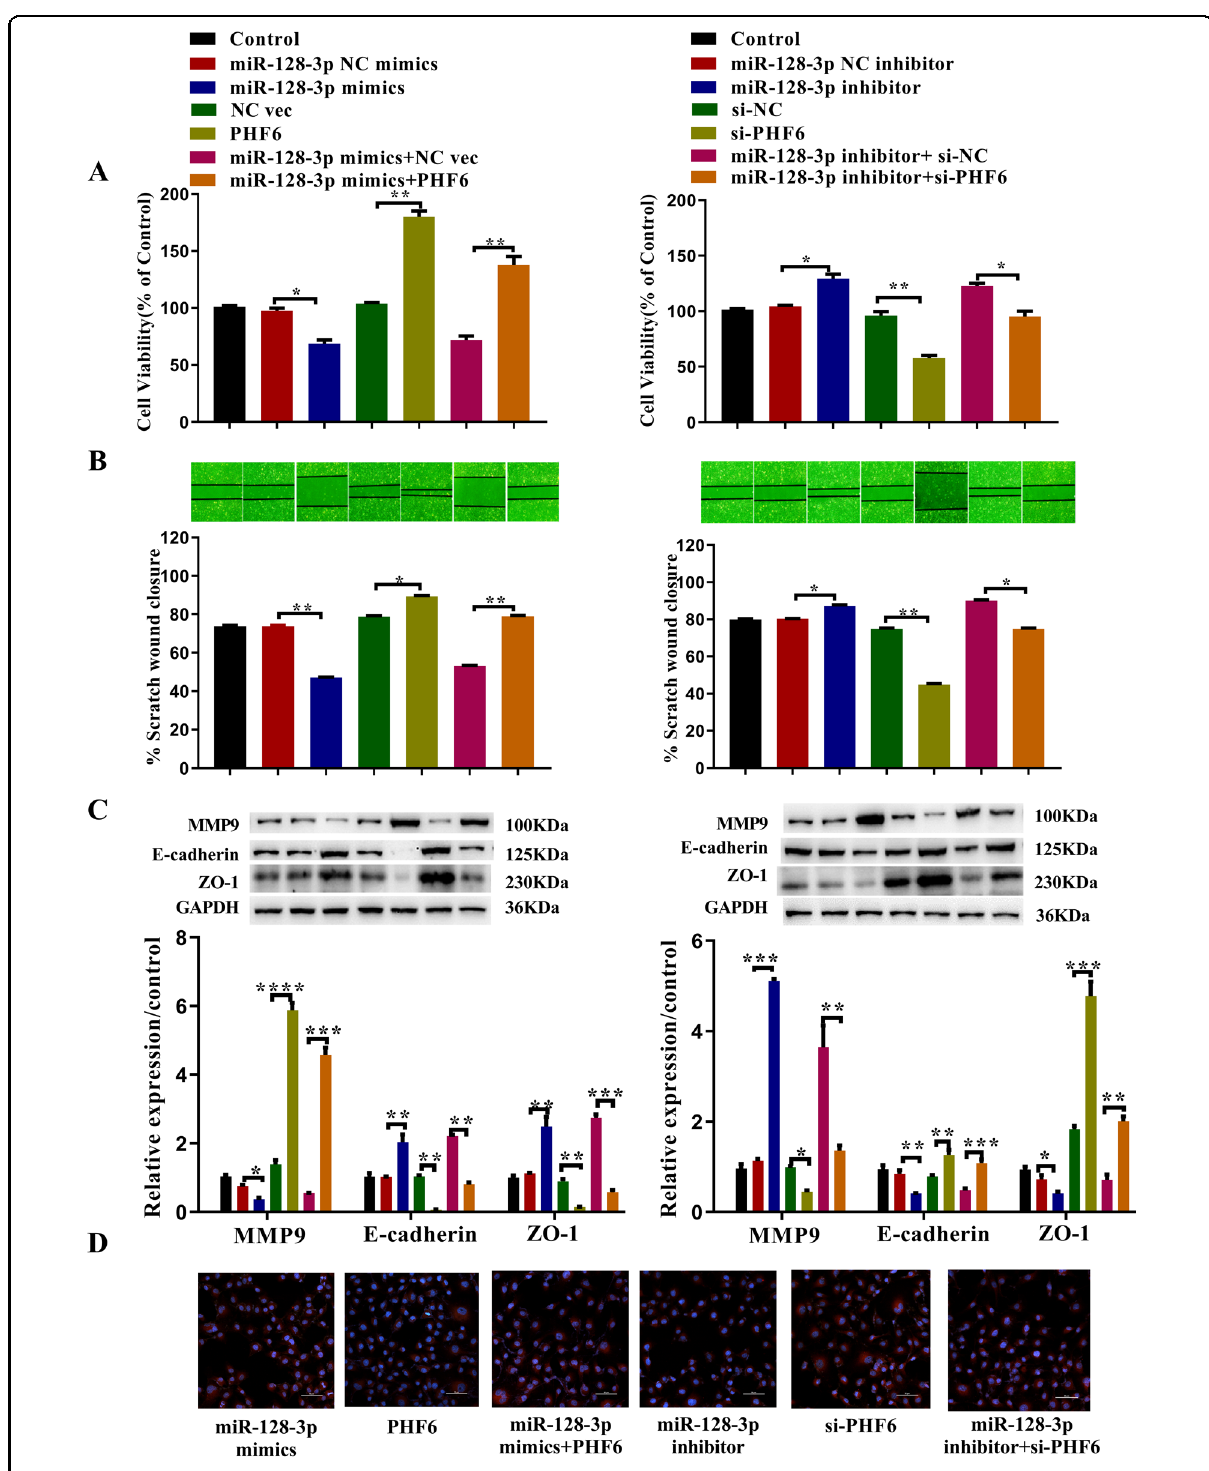
Fig. 7 Overexpression of PHF6 can rescue the effect of miR-128-3p mimic on IEC-6 cells. A Cell viability ( n = 3), B cell migration ability ( n = 3), C MMP9, E-cadherin and ZO-1 were analyzed using cell counting kit-8 assay, wound healing assay, and western blot, respectively ( n = 3). D Representative immuno fl uorescence analysis showed the content of E-cadherin in treated IEC-6 cells ( n = 3). All data were demonstrated as mean ± SD from three independent experiments performed in duplicate. * p < 0.05, ** p < 0.01, *** p < 0.001, and **** p < 0.0001 were all signi fi cant